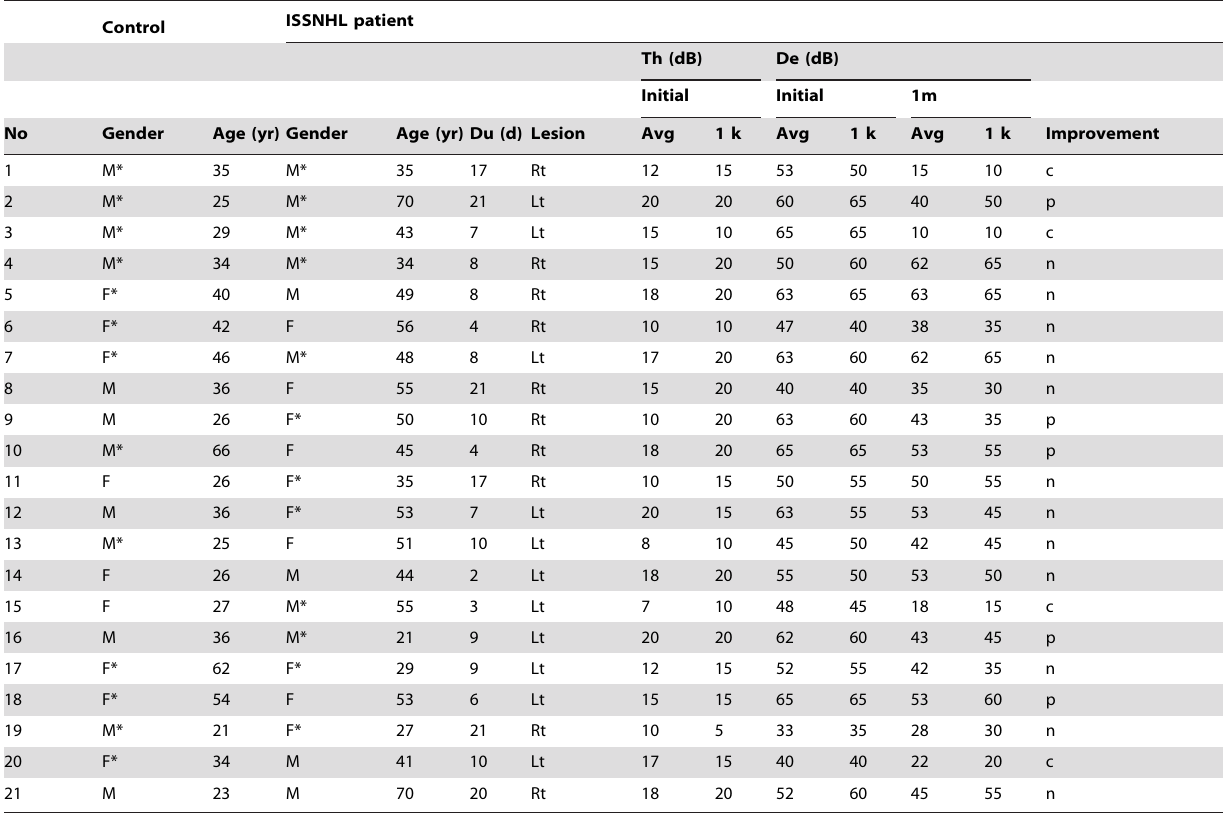
Table 1. General data for all